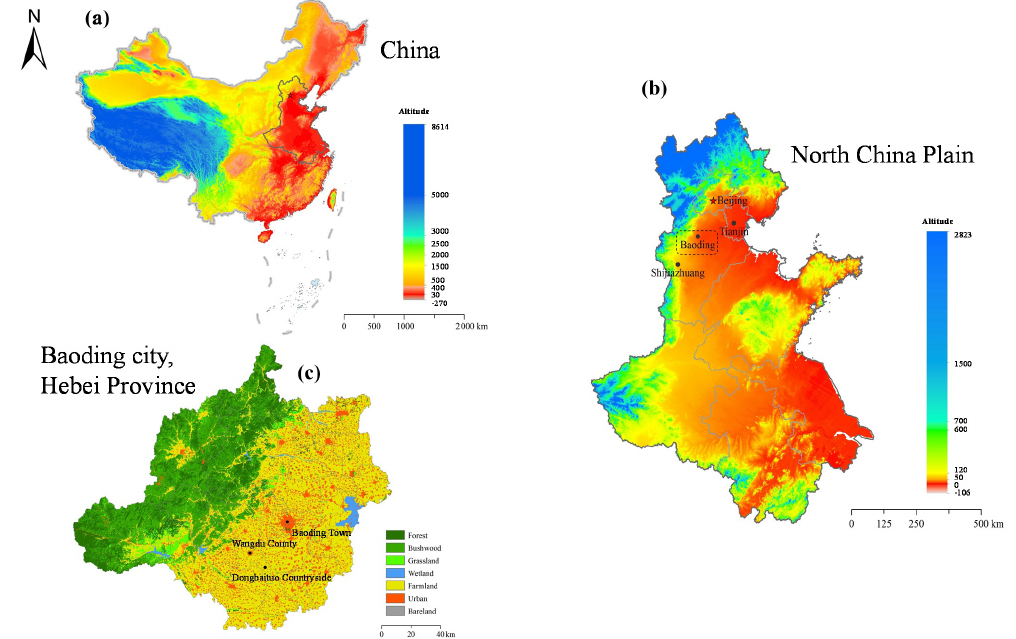
Figure 1. China (a) , the North China Plain (b) and Baoding city in Hebei Province (c) . The locations of sampling sites (BJ, BD, WD and DBT) as well as Tianjin municipality and Shijiazhuang, the provincial capital of Hebei are marked.